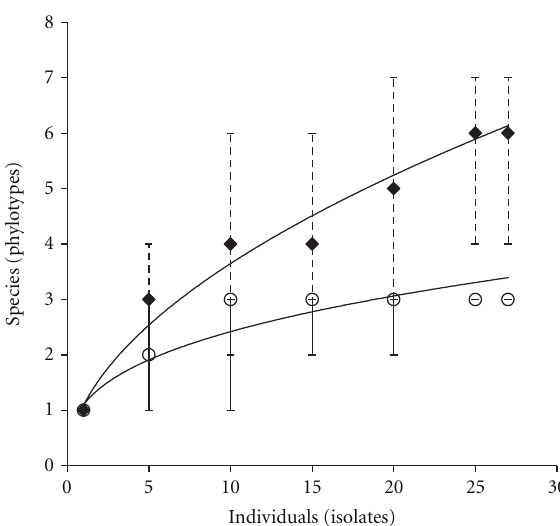
Figure 5: Maximum growth rate, V max , of a subset of summer (solid line) and winter (dashed line) populations as a function of temperature. Error bars represent 95% confidence intervals, based on 3-fold replication and number of genotypes (9 summer, 6